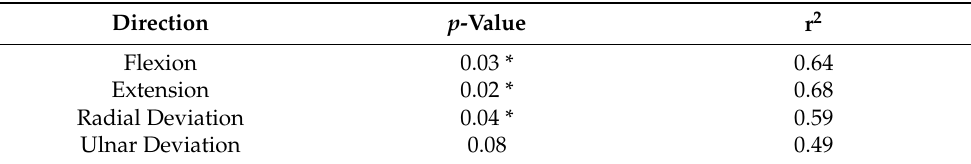
Table 2. Linear regression correlation between isometric wrist force and tracking error of the trained limb at T1 (mean values). Direction p